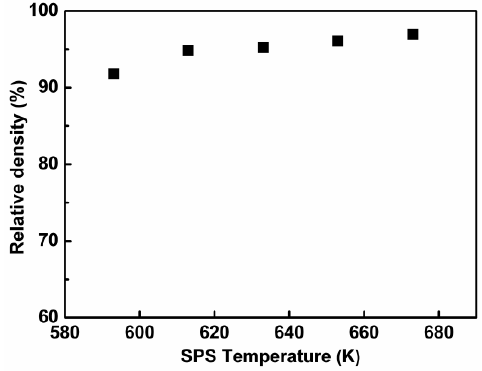
Figure 2. Scanning electron microscopy (SEM) images of ( a ) spark plasma sintering (SPS) 593, ( b ) SPS 613, ( c ) SPS 633 and ( d ) SPS 653 bulk samples; and ( e ) electron probe micro-analyzer (EPMA) images of SPS 633 bulk sample.